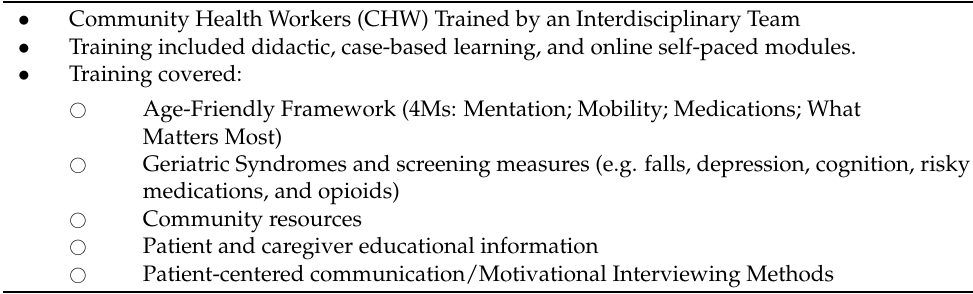
Table 1. Summary of CHW